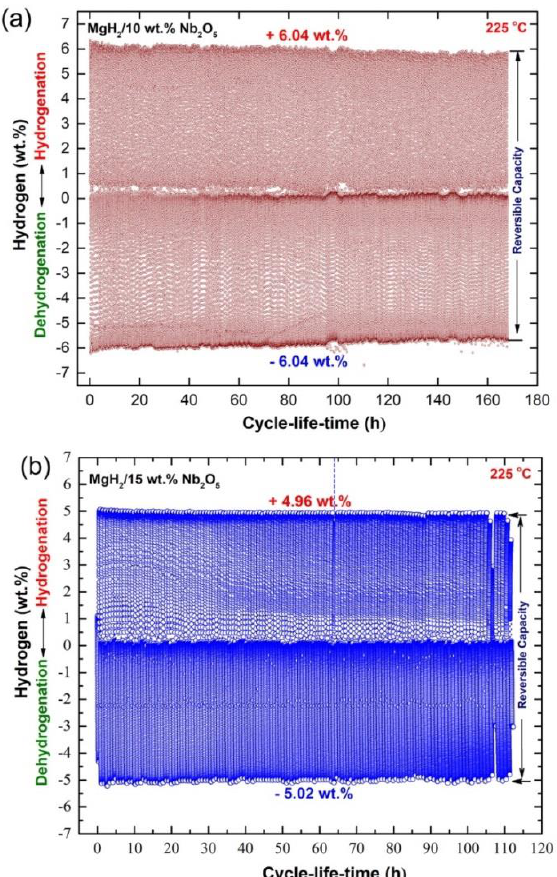
Figure 10. CLT conducted under 10 bar (hydrogenation)/400 mbar (dehydrogenation) of H 2 at 350 °C for Mg-rods obtained after 200 passes. The as-CR rods were RBM for 100 h and then CR for 100 passes. The as-CR powders obtained after 100 passes were individually RBM with Nb 2 O 5 powders of ( a ) 10 wt.% and ( b ) 15 wt.%.